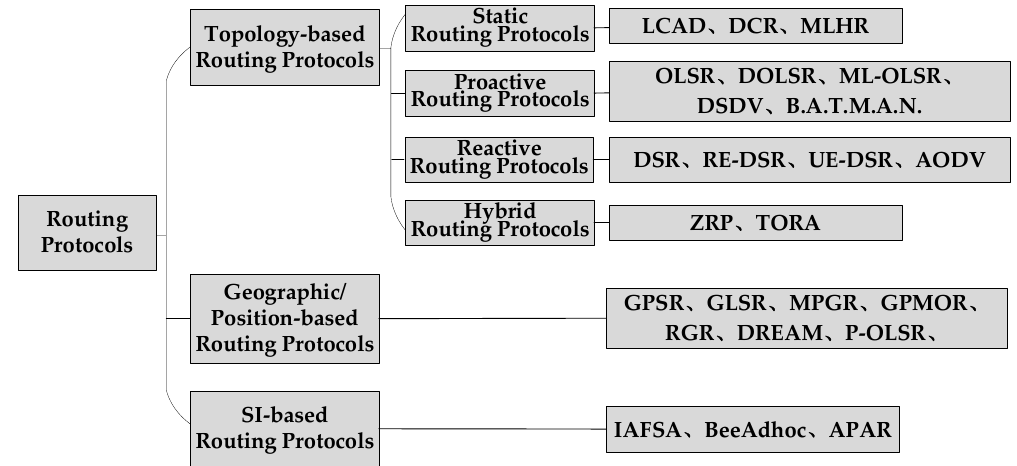
Figure 7. Classification of all routing protocols summarized in this article.